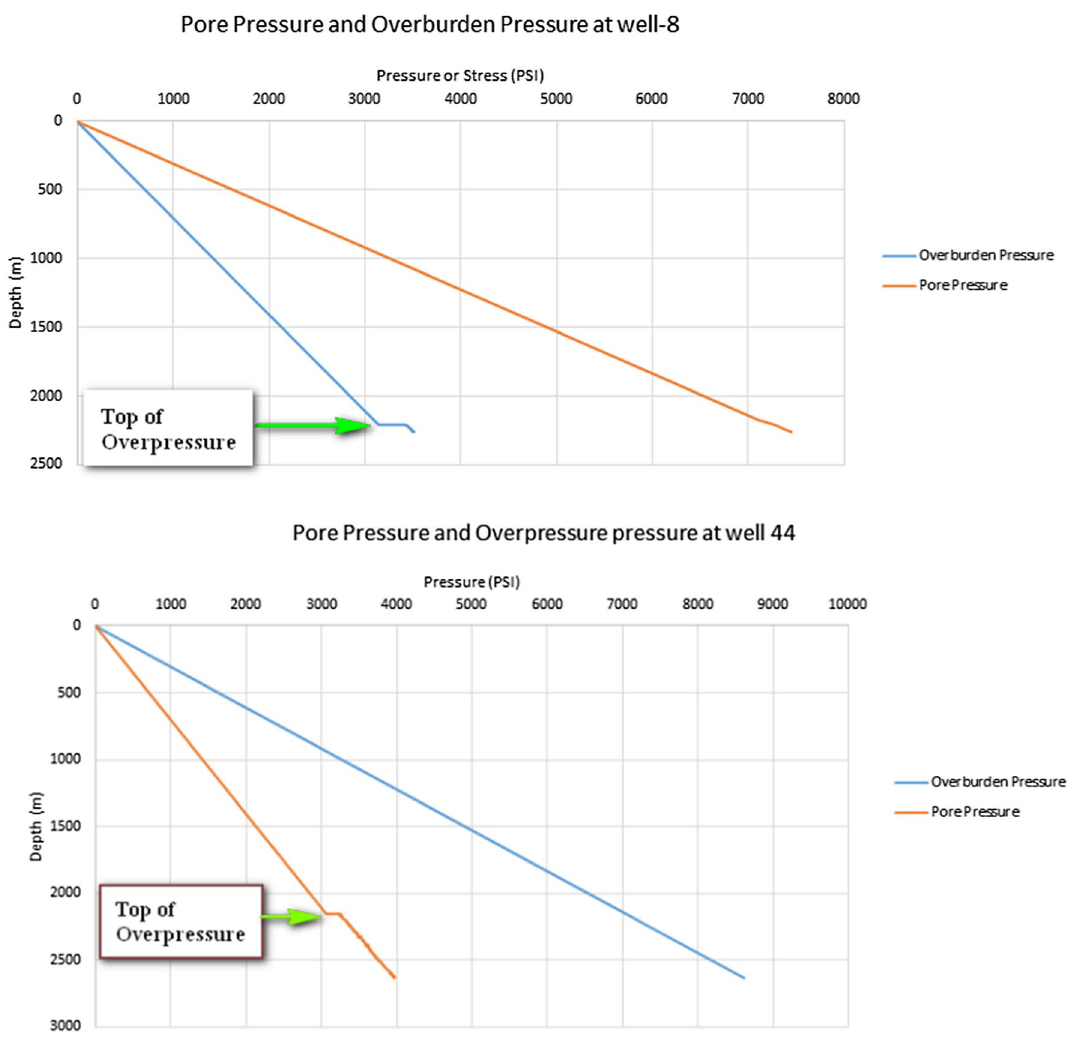
Fig. 5 The pore pressure (red) and overburden pressure (blue) at well no. 44. The overpressure zone is identified at a depth of 2200 m. The pres- sures are measured in